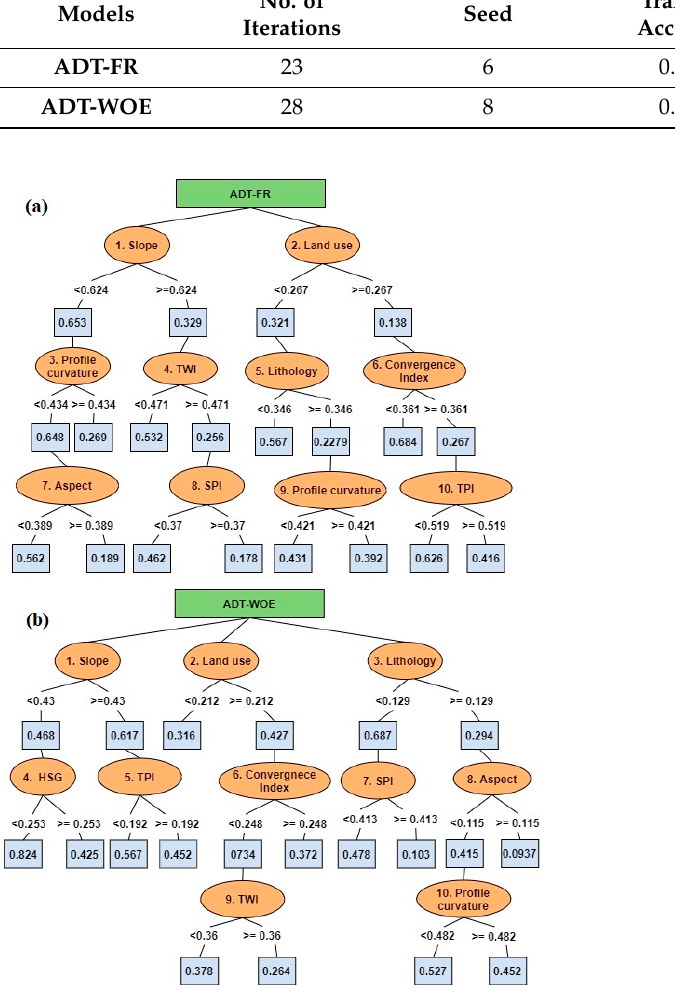
Figure 12. Optimally pruned Decision Tree Structure for ADT based ensembles (( a ) ADT-FR and ( b ) ADT-WOE ensembles). ( b ) ADT-WOE